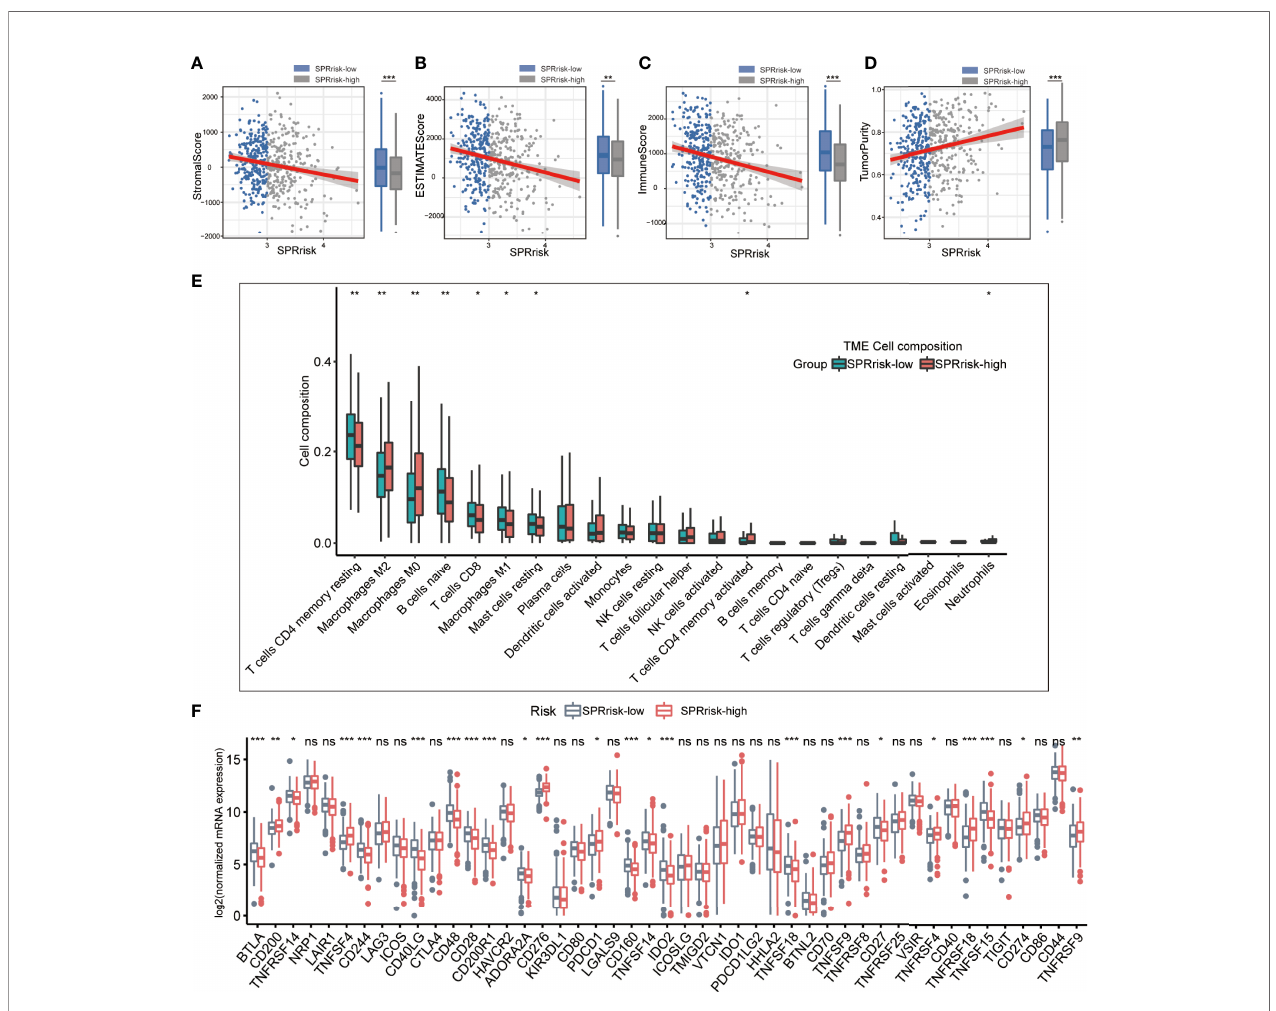
FIGURE 5 | Landscape of immune and stromal cell in fi ltrations in the low- and high-risk groups. (A – D) Comparison of ESTIMATE scores, immune scores, stromal scores, and tumor purity between the high- and low-risk groups. (E) The immune cell in fi ltration levels of 22 immune cell types between the low- and high-risk groups for patients with lung adenocarcinoma. (F) Analyses for the expression of immune checkpoint genes in the high- and low-risk groups. * P < 0.05, ** P < 0.01, *** P < 0.001, and ns (no signi fi